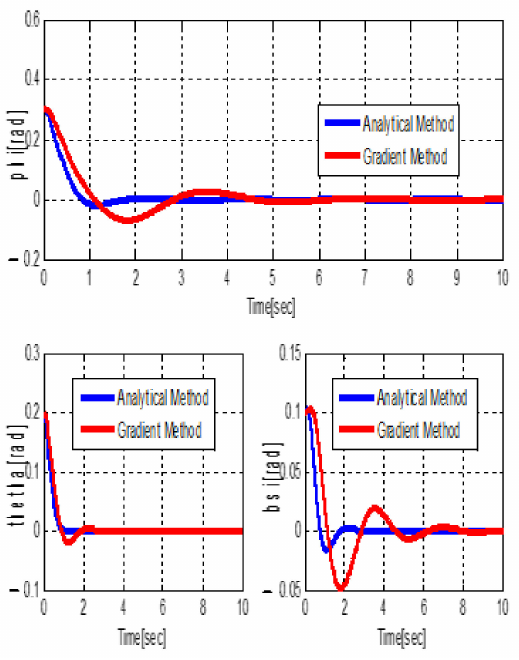
Figure 8. Stabilization of φ , θ , ψ